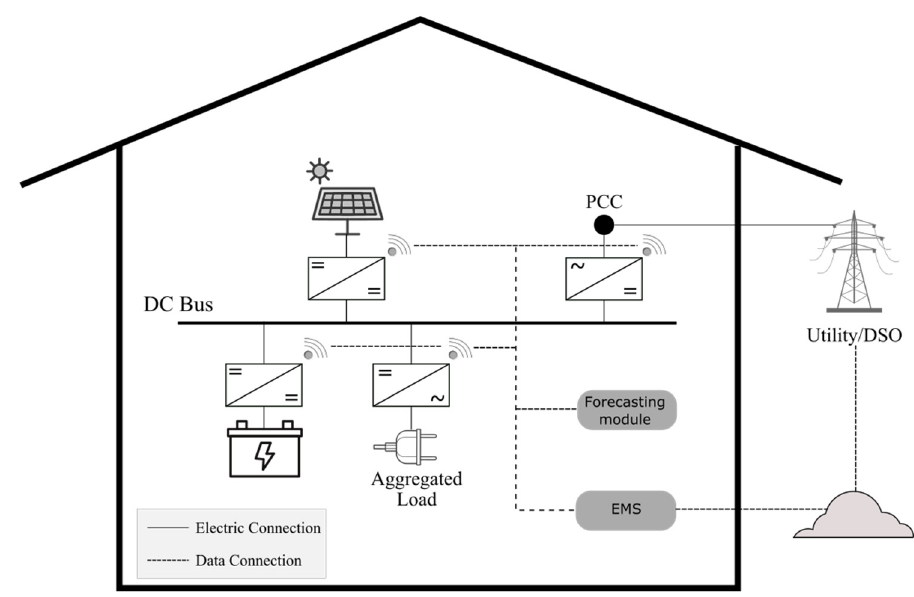
Figure 2. Representation of the elements of the household considered in the study. Table 1. Parameters of the energy management system (EMS) and of the energy market.